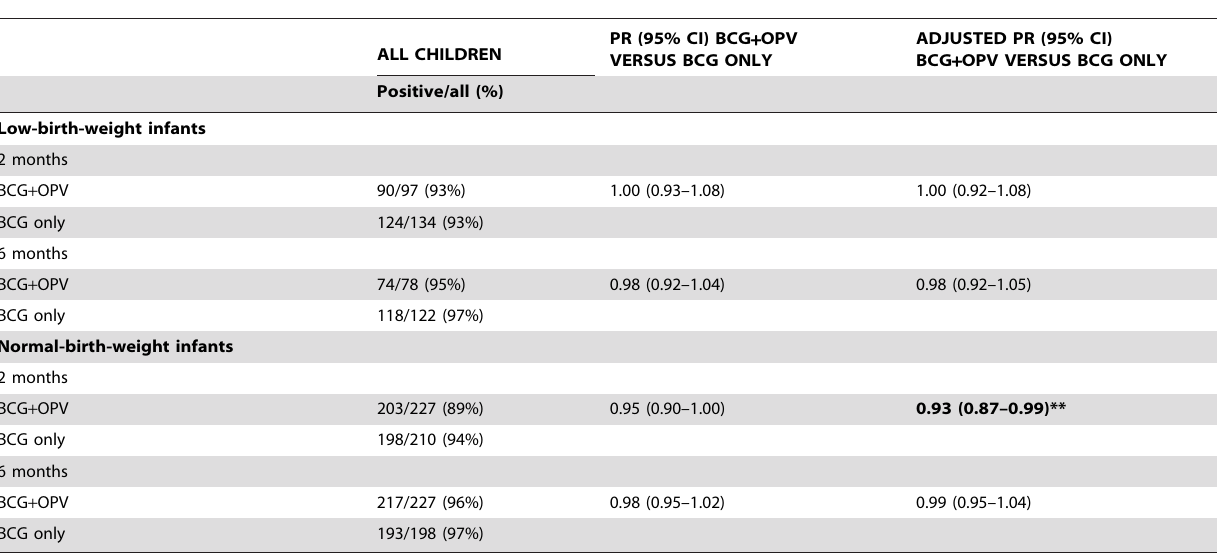
Table 5. The effect of receiving OPV with BCG at birth on the likelihood of being scar positive at age 2 and 6 months.